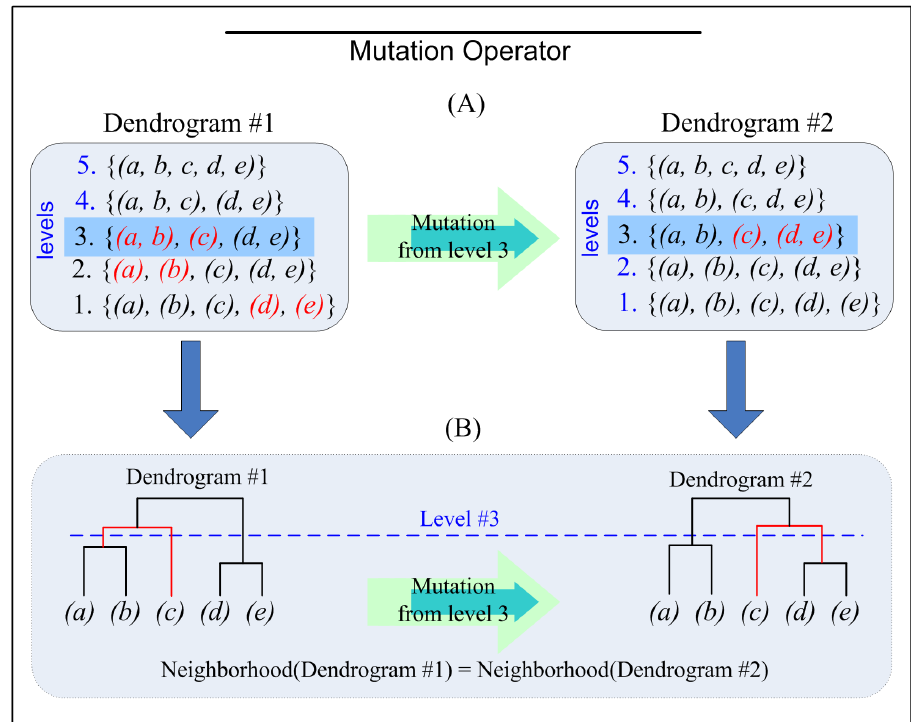
Figure 3: A hypothetical example summarizing the running of the mutation operator defined for the EMHC method. (A) shows the mutation process from the internal structure of the dendro- grams whereas (B) shows the same, but from the graph of the